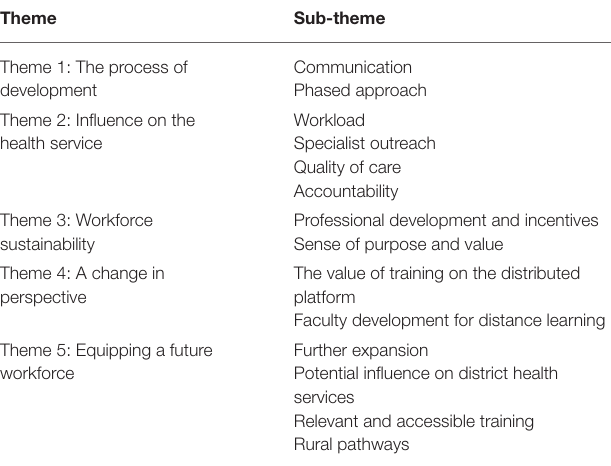
TABLE 2 | Themes and